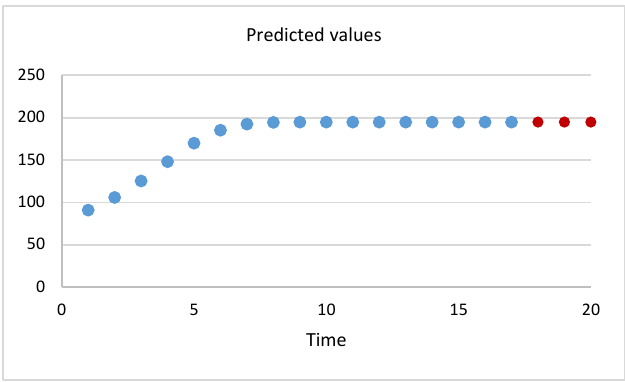
Figure 6. Predicted values by proposed model for dataset 2.